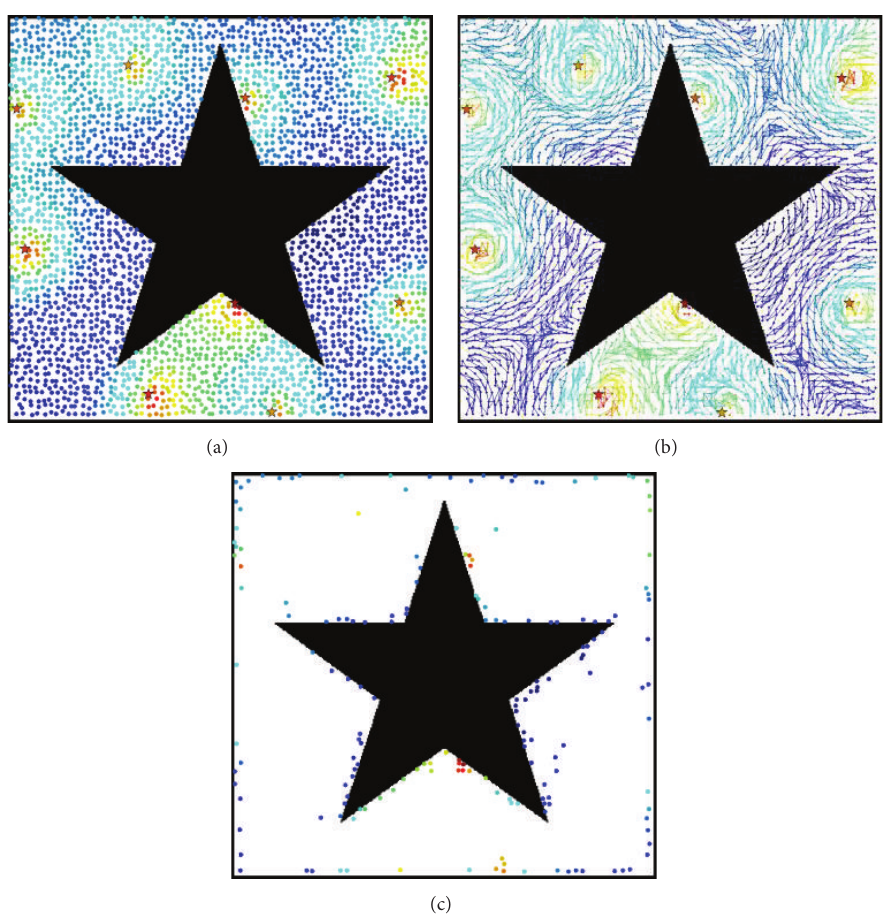
Figure 6: A concentration map and semi-iso-contours. The virtual sources are marked as star. The hotter colour represents higher concentration value, while the cooler colour represents lower concentration